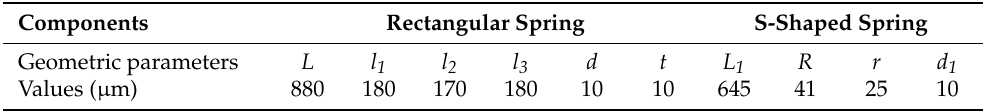
Figure 1. ( a ) Model of the rectangular spring; ( b ) Model of the S-shaped spring; ( c ) The stiffness distribution diagram of the rectangular spring and the S-shaped spring. Table 1. The main geometric parameters of the designed